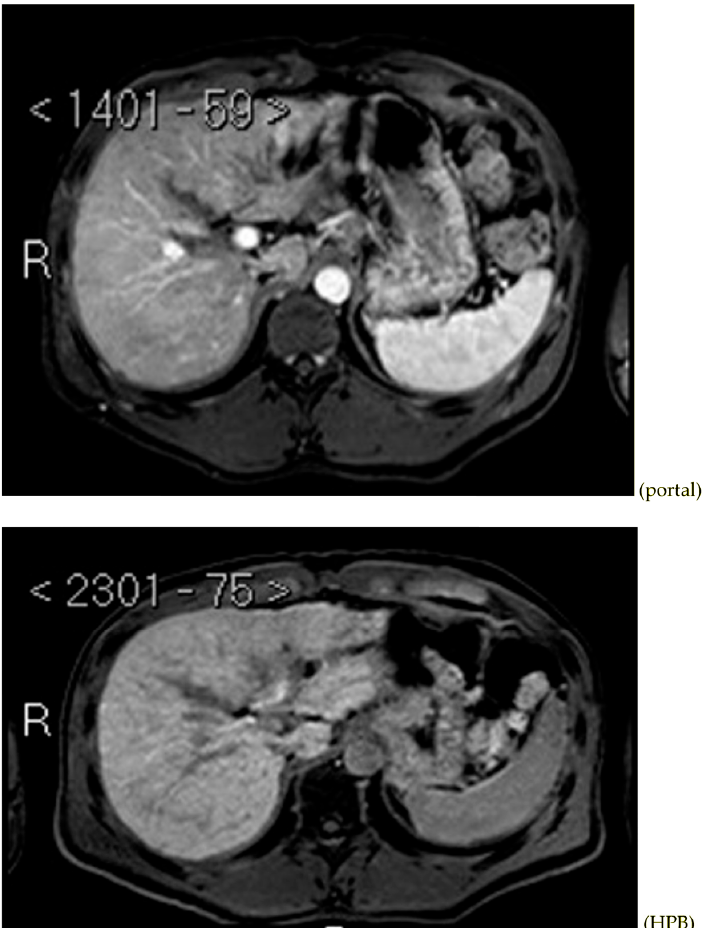
Figure 6. MRI arterial, portal, and HPB phases.